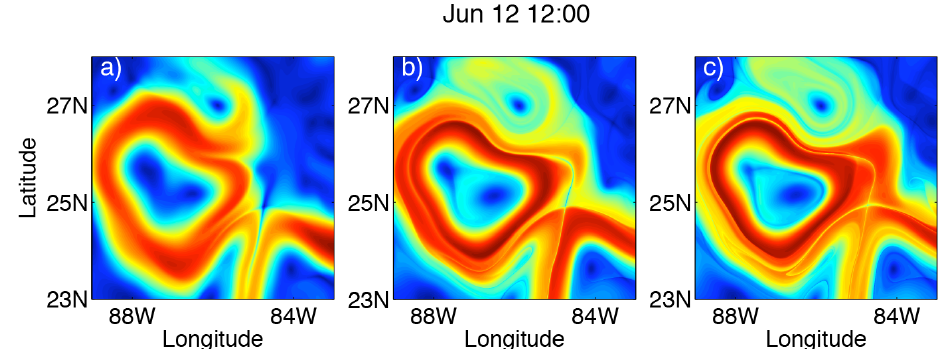
Figure 1. Evaluation of the M function in the Gulf of Mexico for AVISO data. (a) τ = 3 days; (b) τ = 9 days; (c) τ = 15 days. The position of the manifolds is highlighted in this figure.